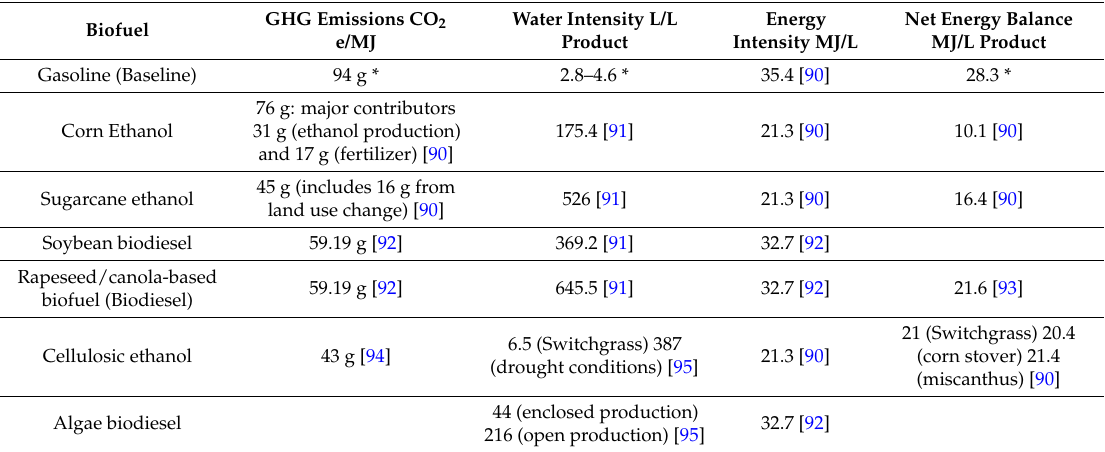
Table 3. Comparison of fuel sustainability